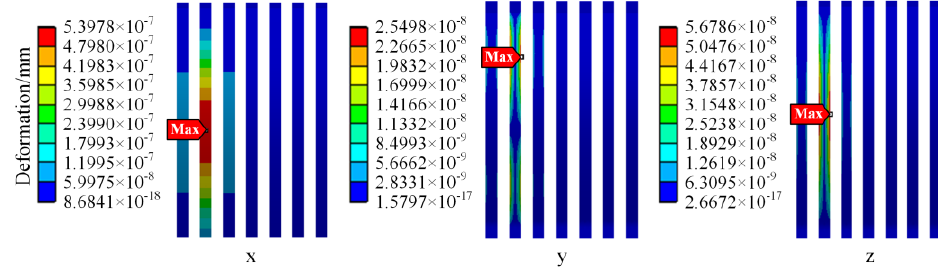
Figure 19. The deformation of bonding wires in different directions.